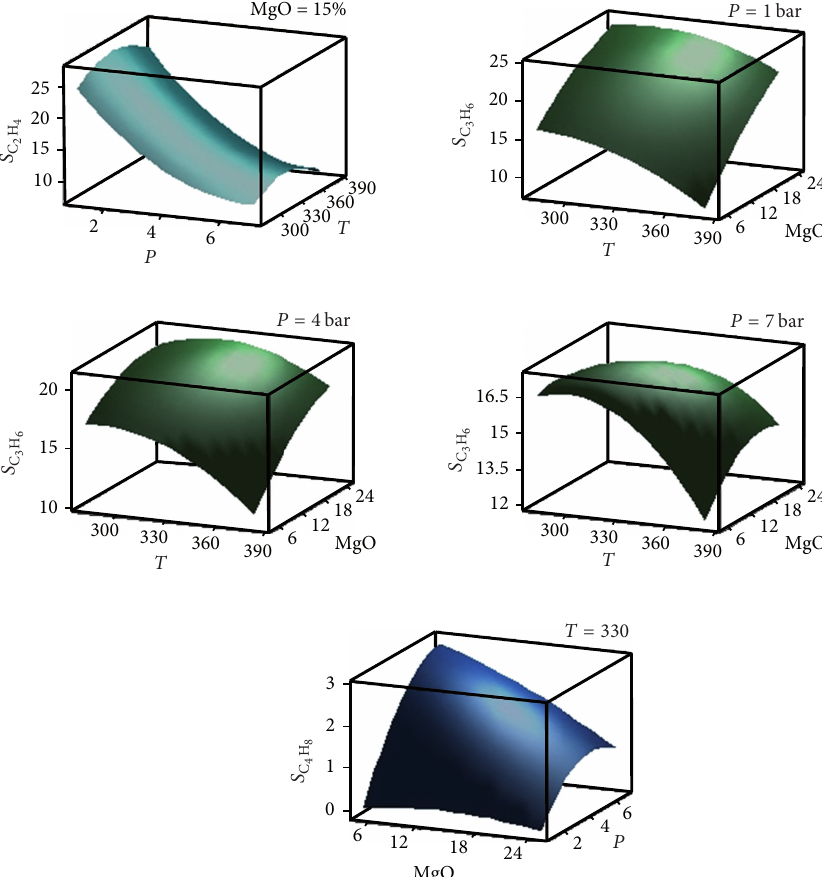
F 4: Effect of temperature, pressure, and structural promoter on ethane, propene, and butylenes selectivity, MgO increases the propene selectivity, and pressure decreasses the propene selectivity while increases the butylenes selectivity. T 3: Effect of MgO loading on BET results of catalyst. MgO support loading